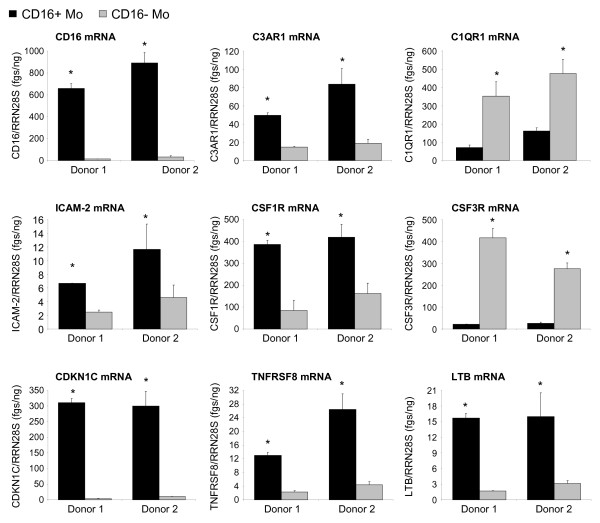
Real-time RT-PCR validation of microarray results. The expression of CD16, C3AR1, C1QR1, ICAM-2, CSFR1, CSF3R, CDKN1C, TNFRSF8, and LTB mRNA was quantified by SYBR Green real time RT-PCR in CD16+ and CD16- Mo. The concentration of each gene was normalized to the 28S rRNA internal control and expressed as fgs RNA of a target gene per 1 ng rRNA28S. Depicted are results (mean ± SD of triplicate wells; *, p < 0.05, unpaired t-test, CD16+ versus CD16- Mo) obtained with matched cells from 2 different healthy donors.